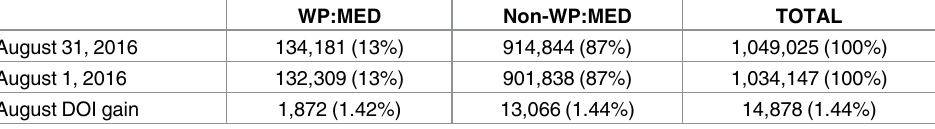
Table 5. Number of total DOI citations that appeared in WP:MED and non-WP:MED during August